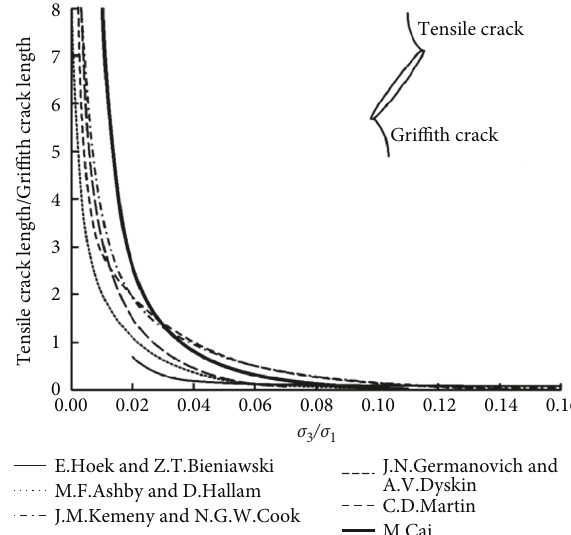
Figure 3: Influence of principal stress ratio on crack mode